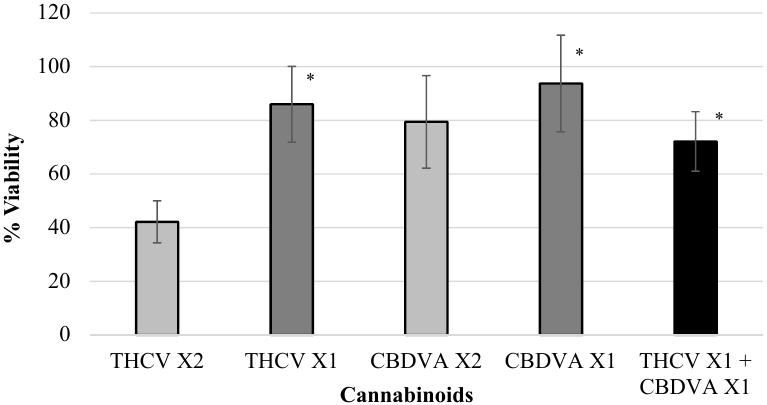
Figure 6. Viability of polyp cells exposed to THCV and CBDVA. The cannabinoid combination THCV + CBDVA showed no synergistic effect (* p > 5, Bliss equation calculation = 0.01). Legend: tetrahydrocannabivarin (THCV), cannabidivarinic acid (CBDVA).